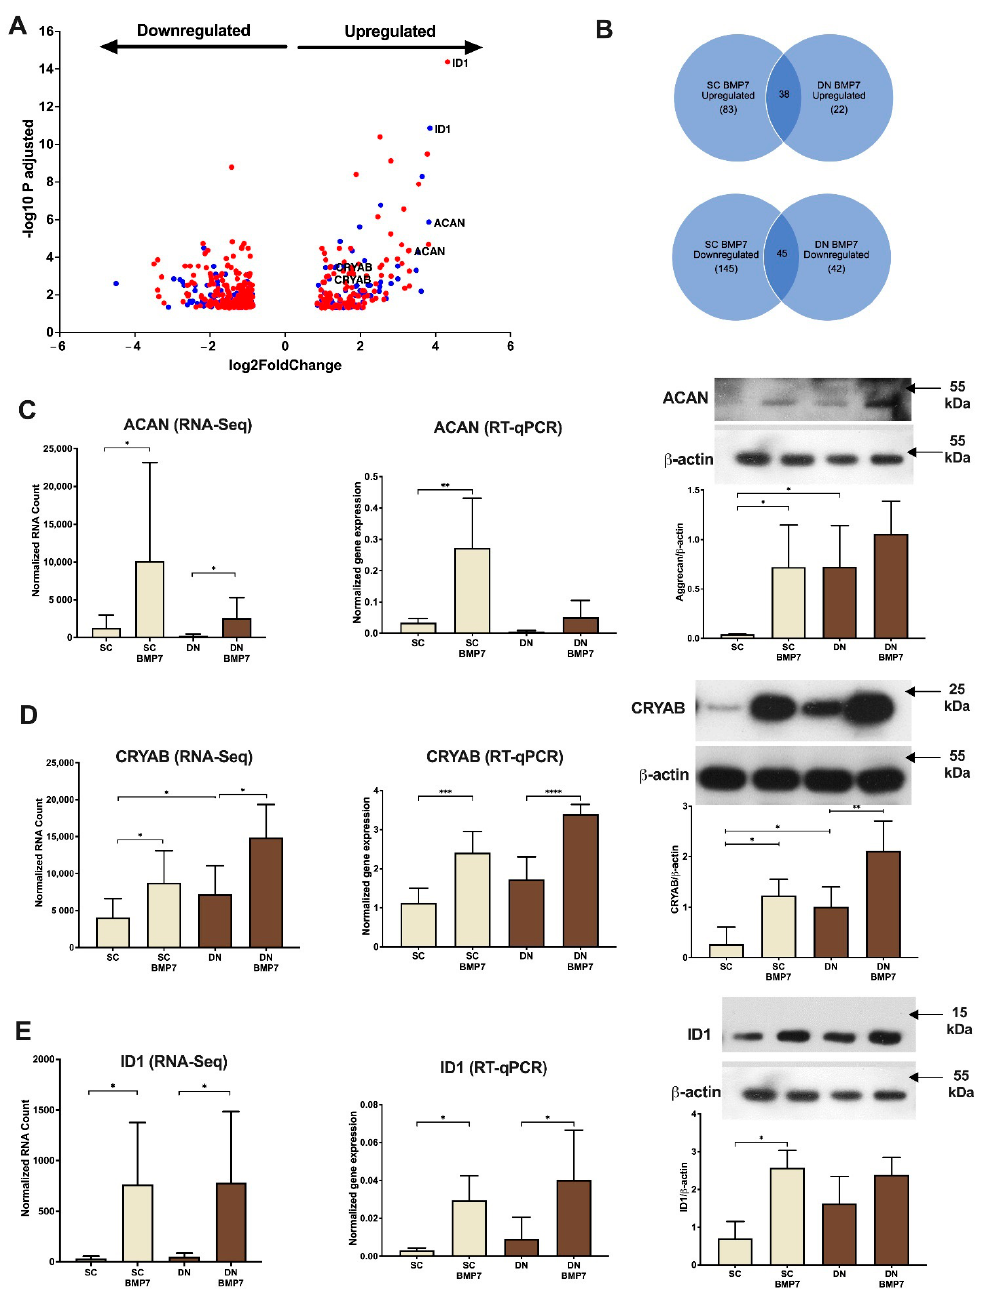
Figure 7. Genes upregulated upon BMP7 treatment in SC and DN derived differentiated adipocytes. SC and DN preadipocytes were differentiated and treated as in Figures 1–6. ( A ) Volcano plot illustrating each of the upregulated genes in SC (red) and DN (blue) depots upon BMP7 treatment. ( B ) Venn-diagram showing the genes commonly up- or downregulated by BMP7 in SC and DN derived adipocytes. Gene expression of ( C ) ACAN, ( D ) CRYAB, and ( E ) ID1 as determined by RNA-sequencing ( n = 9) and RT-qPCR ( n = 5), followed by their respective protein expression ( n = 5). Data presented as mean ± SD. RT-qPCR was normalized to GAPDH, protein expression was normalized to β -actin. * p < 0.05, ** p < 0.01, *** p < 0.001, **** p < 0.0001. Statistics: GLM (RNA- sequencing), one-way ANOVA with Tukey’s test (RT-qPCR and densitometry of western